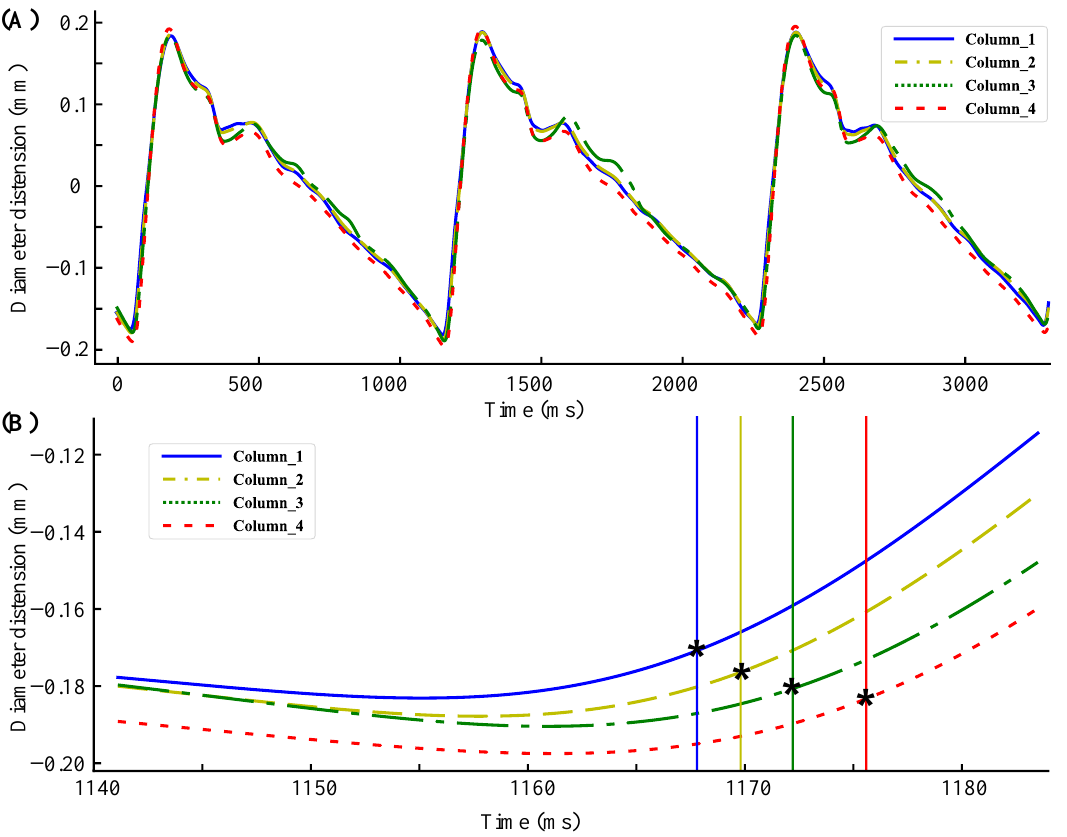
Figure 7. ( A ) Carotid aretery diameter distension waveforms of three cardiac cycles. ( B ) Delay details of the diameter distension waveforms. * represents the maximum point of the second derivative. In the hardware, the data were obtained with a frame rate of 2.5 KHz and was interpolated to 10 KHz by the software, ensuring the resolution of the time reference point to 0.1 ms. Figure 8 shows the linear fitting line of the same subject in three consecutive cardiac cycles. The horizontal and vertical coordinates of the graph are the time and beam position, respectively, and the slope of the fitting line is the local PWV. The calculated local PWV is 4.09 m/s, 3.85 m/s, and 4.11 m/s, respectively.